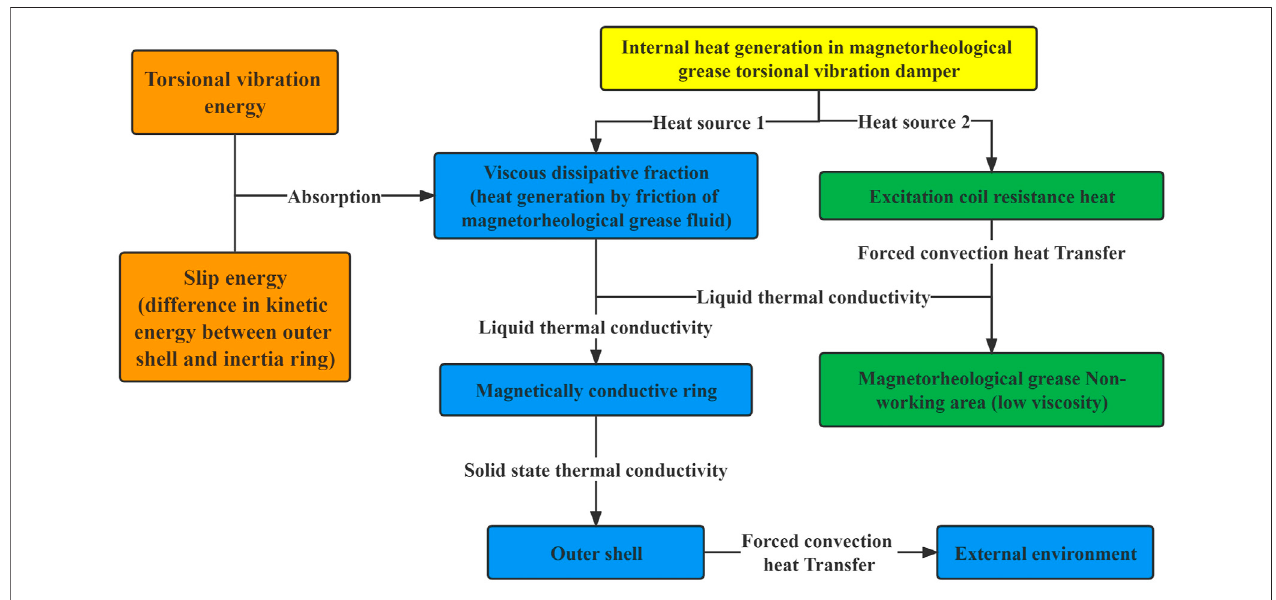
FIGURE 5 | Thermal conductivity